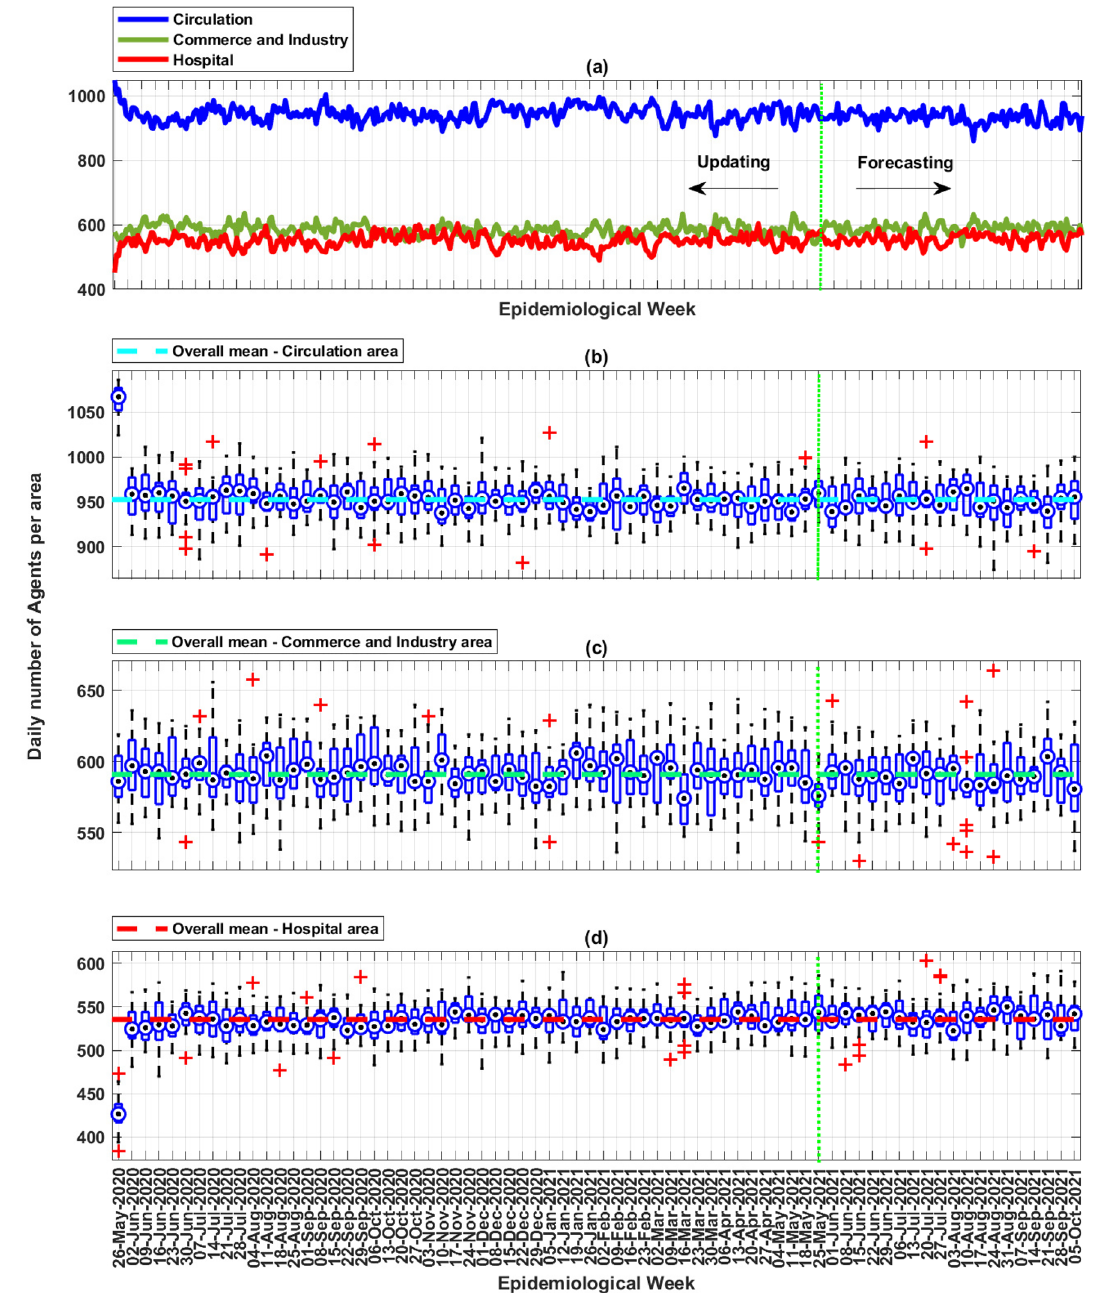
Figure 16. ( a ) Weekly density of agents by specific region with applying the social distancing policy—19th solution. ( b ) Boxplot analysis of all 17 solutions regarding weekly density in the circulation area. ( c ) Boxplot analysis of all 17 solutions regarding weekly density in the commercial and industrial areas. ( d ) Boxplot analysis of all 17 solutions regarding weekly density in the hospital